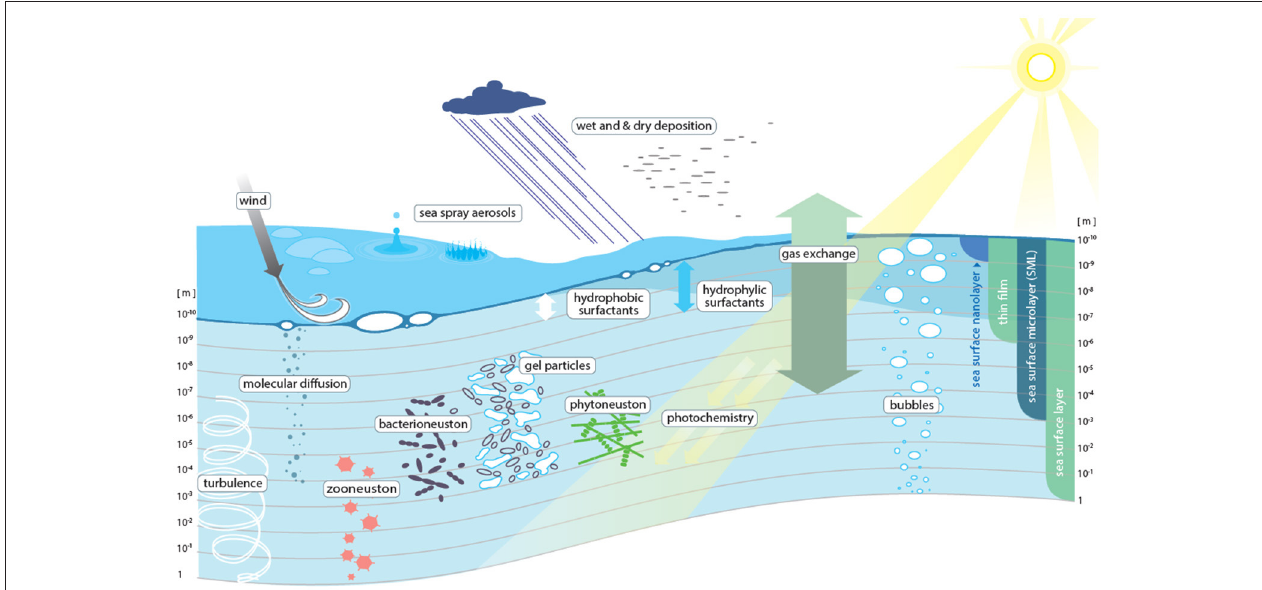
FIGURE 1 | Conceptual view of the processes determining transport across the sea surface microlayer